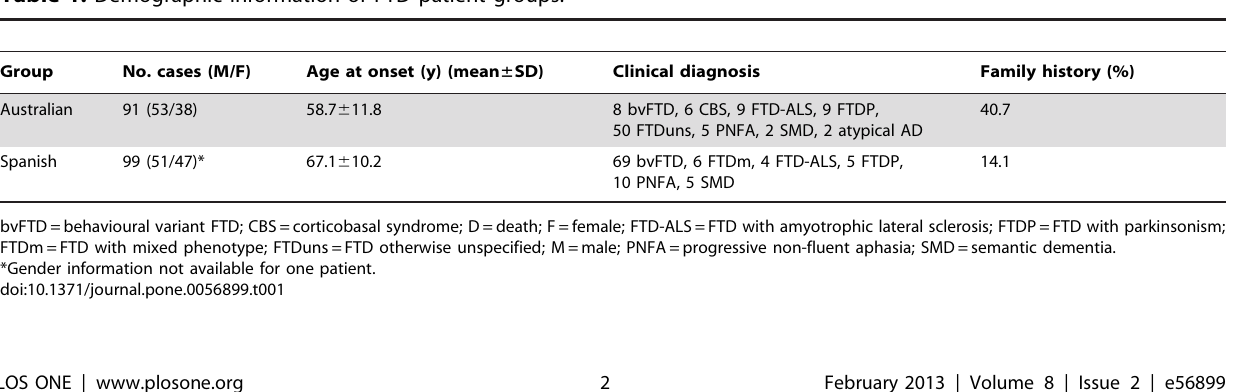
Table 1. Demographic information of FTD patient